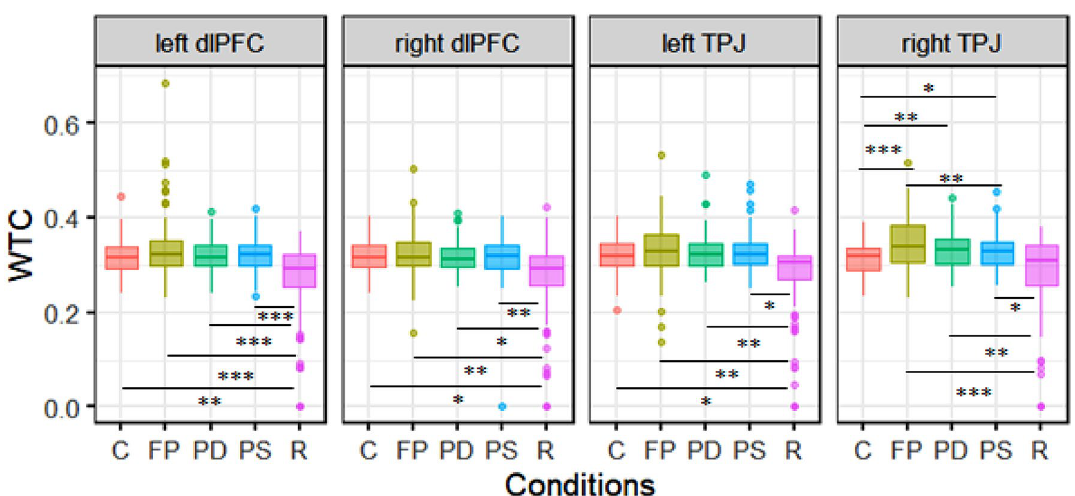
Figure 6. Box plots illustrating WTC values for each experimental condition for each region separately. In the right TPJ, Free Play (FP), Prediction-Different (PD) and Prediction-Same (PS) conditions showed higher coherence than during the Control (C) condition, p < .023 and neural synchrony was significantly higher in FP condition as compared to the PS condition, p = .010. Neural synchrony in FP condition was also marginally higher than in C condition in the left DLPFC, p = .057. * p ≤ 0.05, ** p ≤ 0.01, *** p ≤